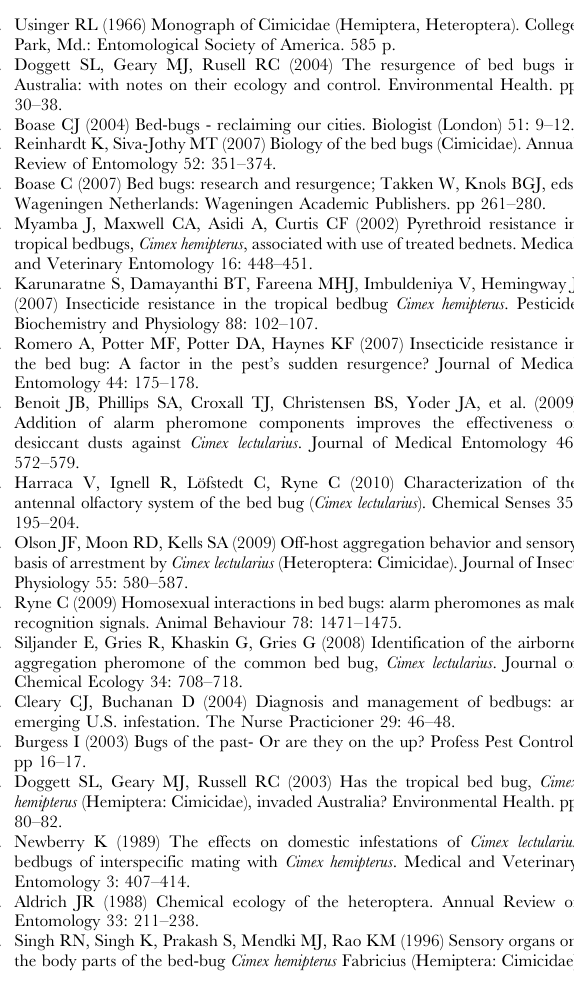
Figure S2 Gas chromatograms of C. lectularius and C. hemipterus and mass spectra of nymph compounds. Representative GC-traces of head space samples from A) C. lectularius and B) C. hemipterus with mass spectra of a) 4-oxo-( E )-2- hexenal, b) 4-oxo-( E )-2-octenal. 4-Oxo-( E )-2-octenal showed a M + of 112, 113 from 13 C and a base peak of 83 plus fragments